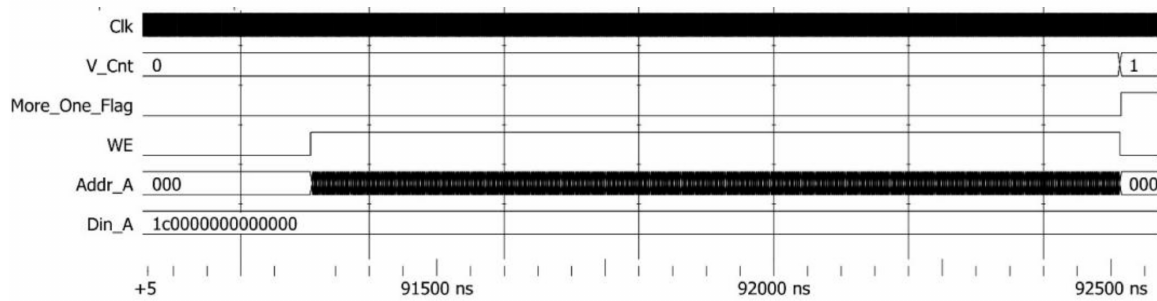
Figure 15. Timing diagram of RAM initialization key signals. The construction of the heterogeneous convolution window requires that the data read from RAM and the data read from FIFO are at the same time. The timing logic of key signals is shown in Figure 16. Both RAM and FIFO have a one-beat read delay. The read-enabled signal of FIFO drives the count of RAM read